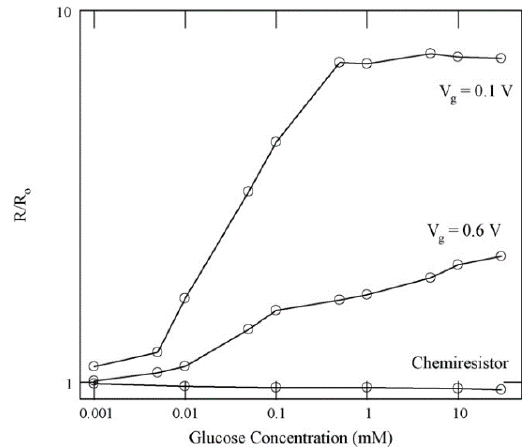
Figure 2. Normalized resistance between the source and drain for Organic electrochemical transistors (OECTs) exposed to different concentrations of glucose solution, at V of 0.1 V and 0.6 V and with no gate